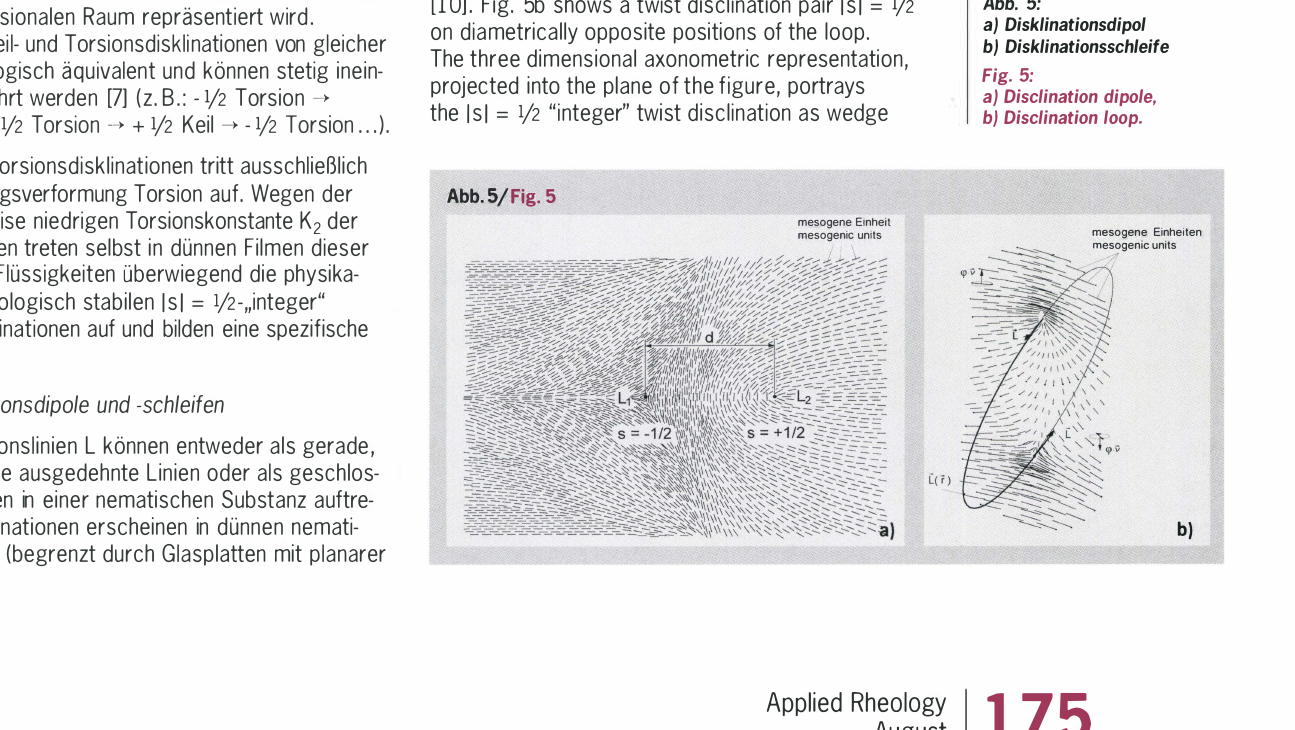
Fig. 5: a} Disclination dipole, b) Disclination